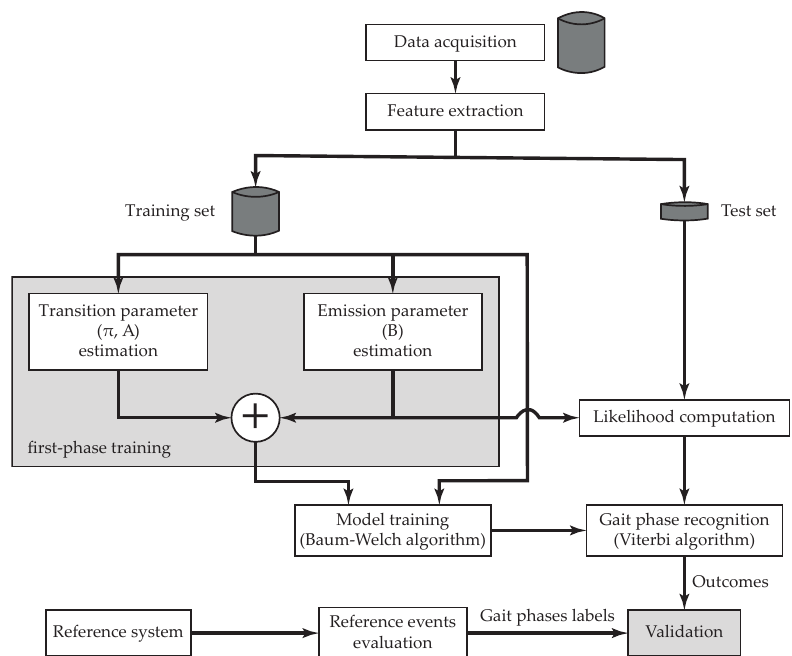
Figure 5. Flowchart that illustrates the validation methodology of HMM. A model is trained by means of the Baum–Welch algorithm, after applying feature extraction to the acquired dataset. The optimal state sequence is then computed through the Viterbi algorithm by using feature vectors from the test dataset, and the performance evaluation is conducted with respect to gait phases labels drawn from the reference